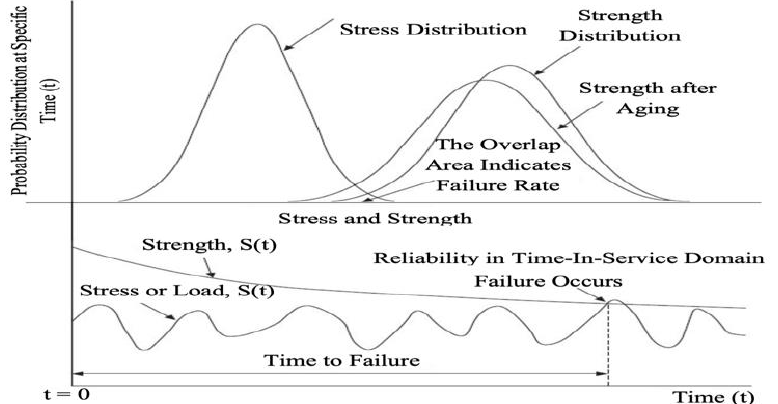
Figure 14. Random probability distribution of stress strength [108].